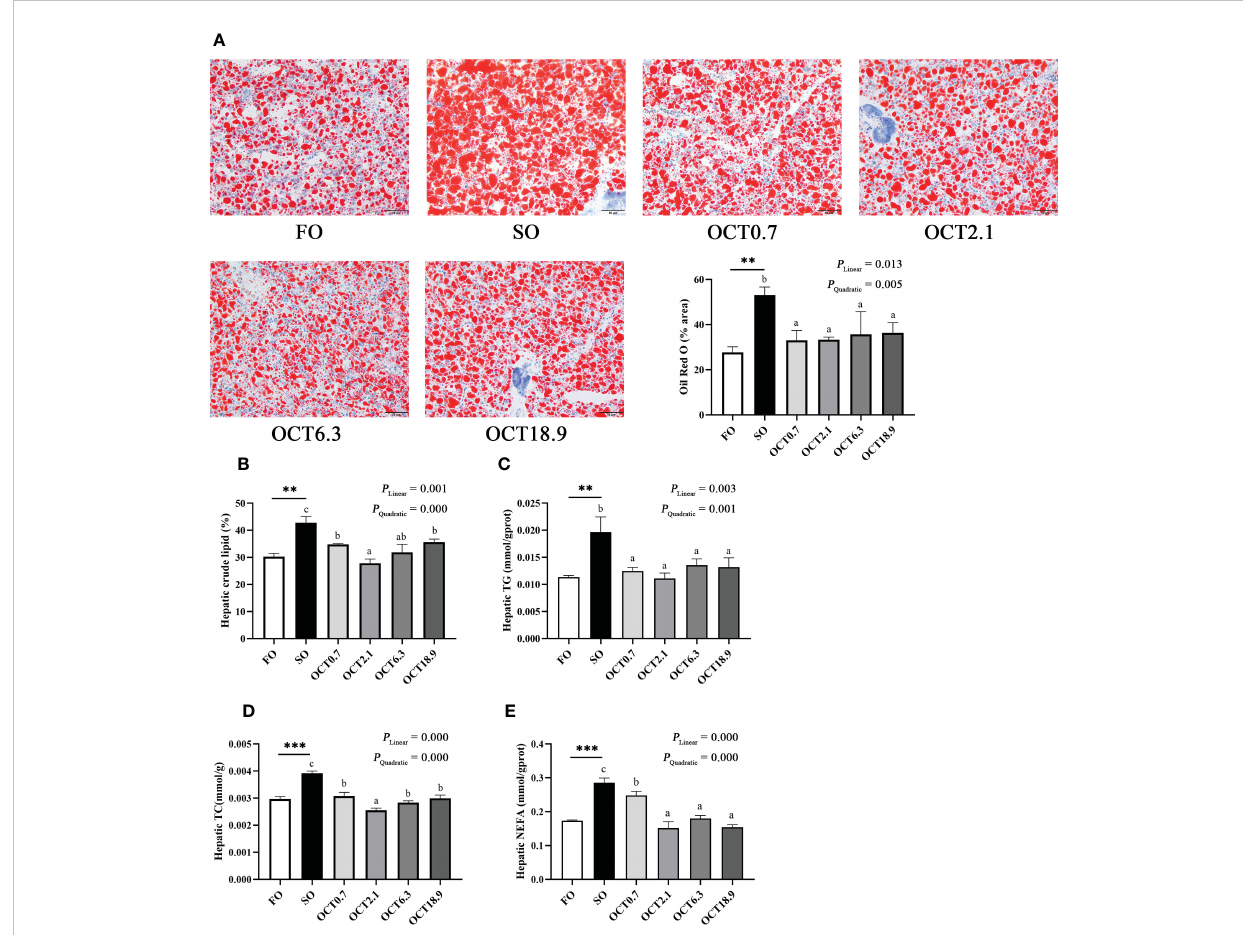
FIGURE 2 Effects of supplemental octanoate on hepatic lipid deposition of large yellow croaker. (A) The oil red O staining results of different dietary treatments (200×, bars = 50 µm), (B) Lipid contents in liver, (C) Total triglyceride contents in liver, (D) Total cholesterol contents in liver, (E) The non-esteri fi ed fatty acids contents in liver. The values were means (n = 3) with their standard errors represented by vertical bars. and the FO group. ∗∗ represent a signi fi cant difference of P < 0.01 between the SO group and the FO group. ∗∗∗ represent a signi fi cant difference of P < 0.001 between the SO group and the FO group. Different letters show signi fi cant difference ( P < 0.05) among OCT treatment groups. Linear trend and Quadratic trend were analyzed by orthogonal polynomial contrasts.